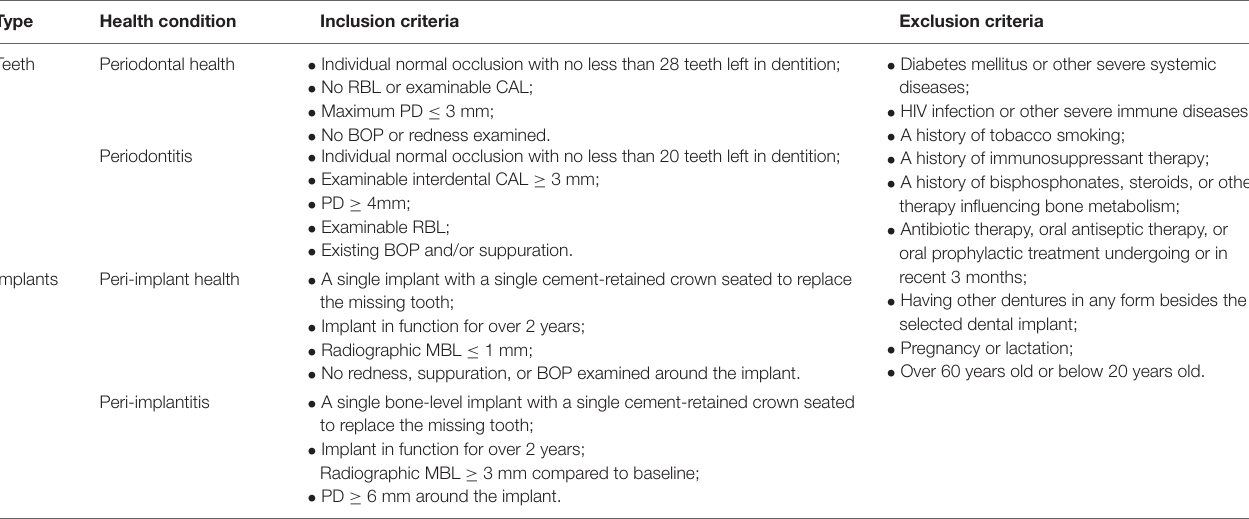
TABLE 1 | Detailed inclusion and exclusion criteria for subject